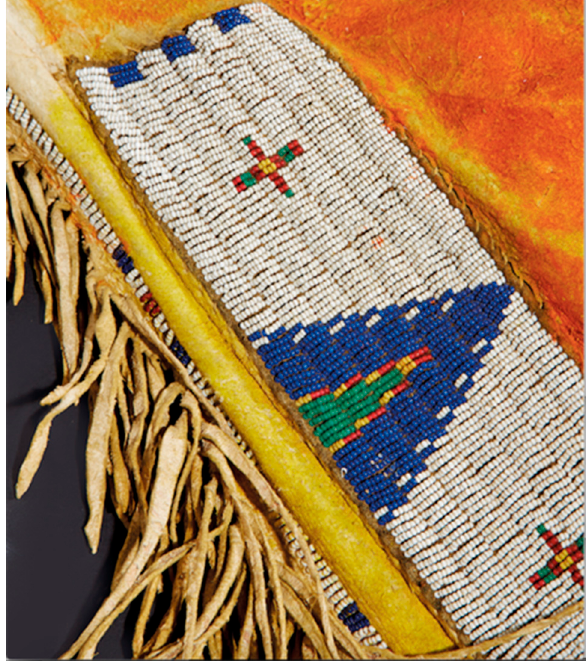
Figure 5. Detail of Plains Indian buckskin leggings (Figure 1), c. 1888, Musée de l’Atelier Rosa-Bonheur, Château de By, Thomery, France. Photograph taken by Christie’s Paris. Used by permission of the Musée de l’Atelier Rosa-Bonheur.